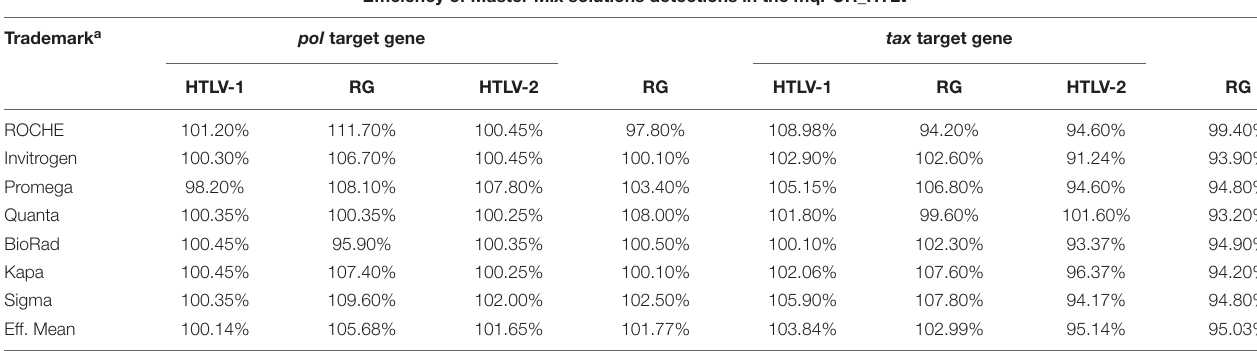
TABLE 4 | Efficiency values of the mqPCR_HTLV assays for detecting HTLV-1 and HTLV-2 ( pol and tax ) and the reference gene (human albumin gene), using seven commercial master mix